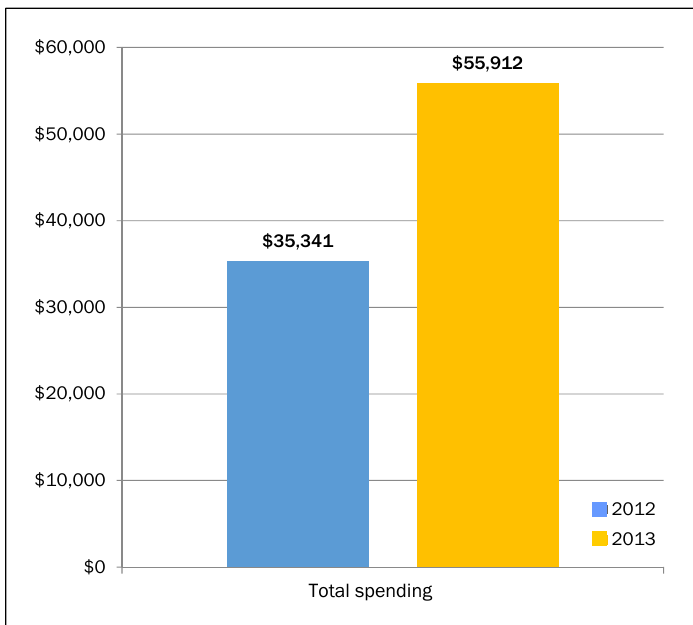
Figure 2. Local Spending by Schools Participating in the Food Hubs and FTS Project, 2012 and